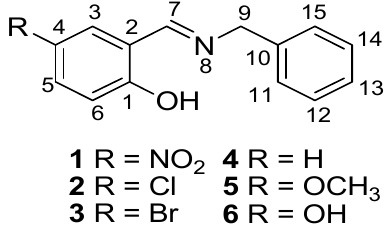
Figure 1. Schiff base derivatives of 1 – 6